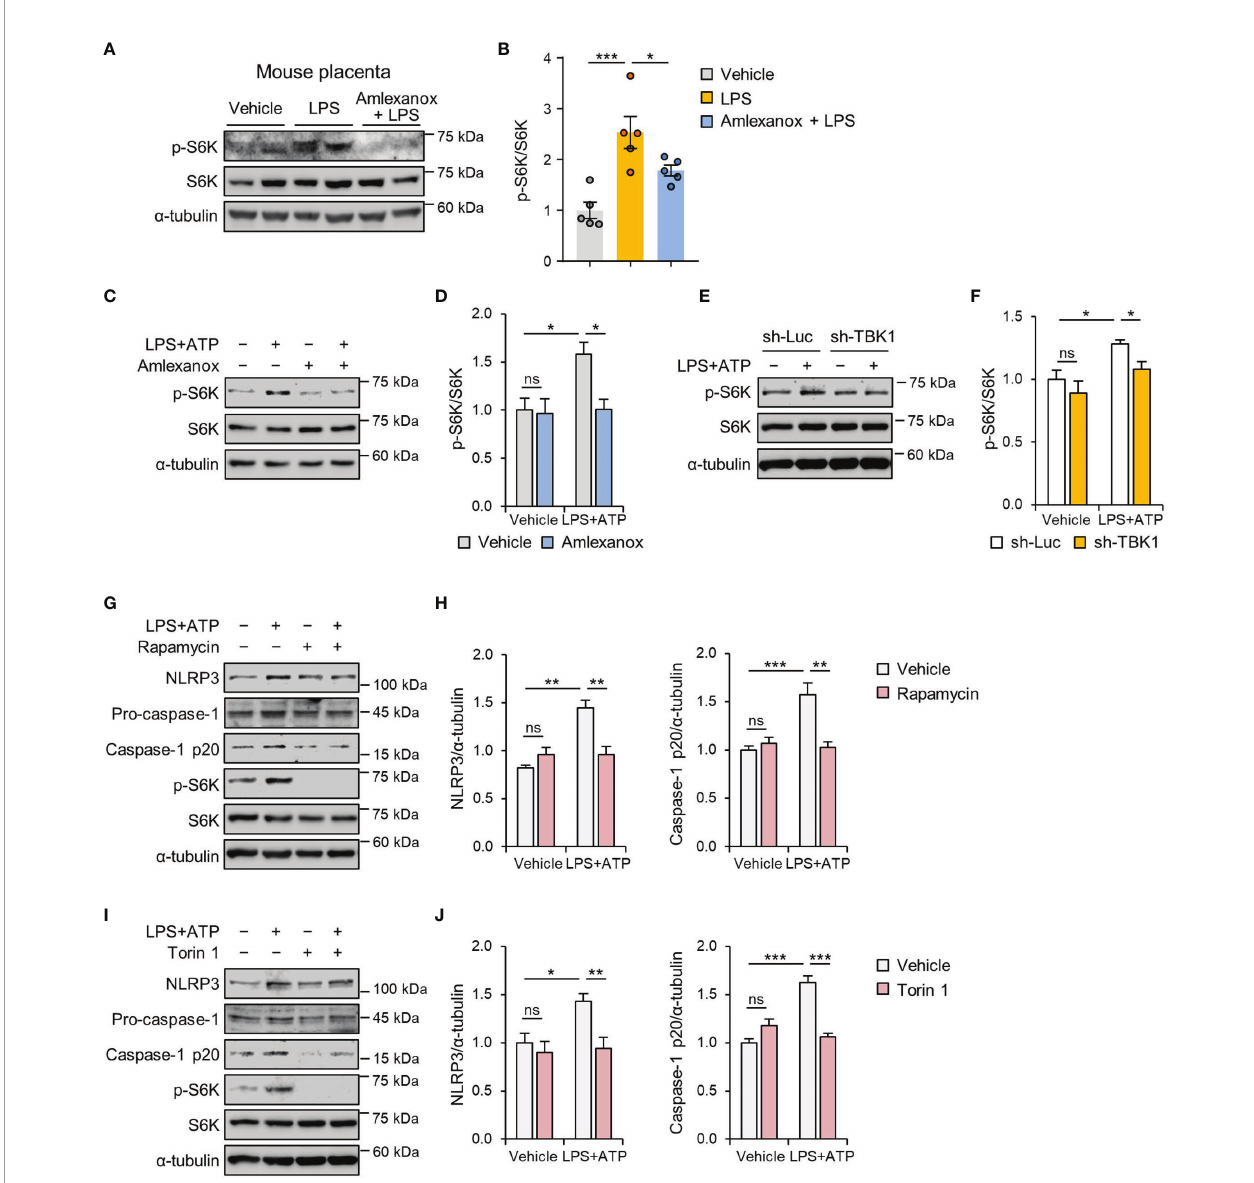
FIGURE 7 | TBK1 de fi ciency suppresses LPS-induced NLRP3 in fl ammasome activation via an mTORC1-dependent mechanism. (A, B) Pregnant mice were intraperitoneally injected with LPS (200 m g/kg) or amlexanox (2.5 mg/kg) on gestation day 17.5, as indicated in the fi gure. Placental tissues were collected from mice and analyzed by immunoblotting with anti-p-S6K and anti-S6K antibodies ( n = 5 per group). (C, D) HTR-8/SVneo cells were treated with 1 m g/mL LPS or 100 µM amlexanox for 24 h, as indicated in the fi gure. Cell lysates were analyzed by immunoblotting with anti-p-S6K and anti-S6K antibodies. a -tubulin served as a loading control. (E, F) HTR-8/SVneo cells were infected with lentiviruses expressing shRNAs targeting luciferase (sh-Luc) or TBK1 (sh-TBK1) and treated with 1 m g/mL LPS for 24 h, as indicated in the fi gure. Cell lysates were analyzed by immunoblotting with anti-p-S6K and anti-S6K antibodies. (G – J) HTR-8/SVneo cells were treated with 1 m g/mL LPS, 100 nM rapamycin, or 250 nM Torin 1 for 24 h, as indicated in the fi gure. Cell lysates were analyzed by immunoblotting with anti-NLRP3, anti- caspase-1, anti-p-S6K, and anti-S6K antibodies. a -tubulin served as a loading control. Band intensities were quanti fi ed and normalized to control band intensities. Data are shown as means ± SEM. Results are representative of at least three independent experiments. * p < 0.05; ** p < 0.01; *** p < 0.001; ns, not signi fi cant (One- way ANOVA, followed by Tukey ’ s